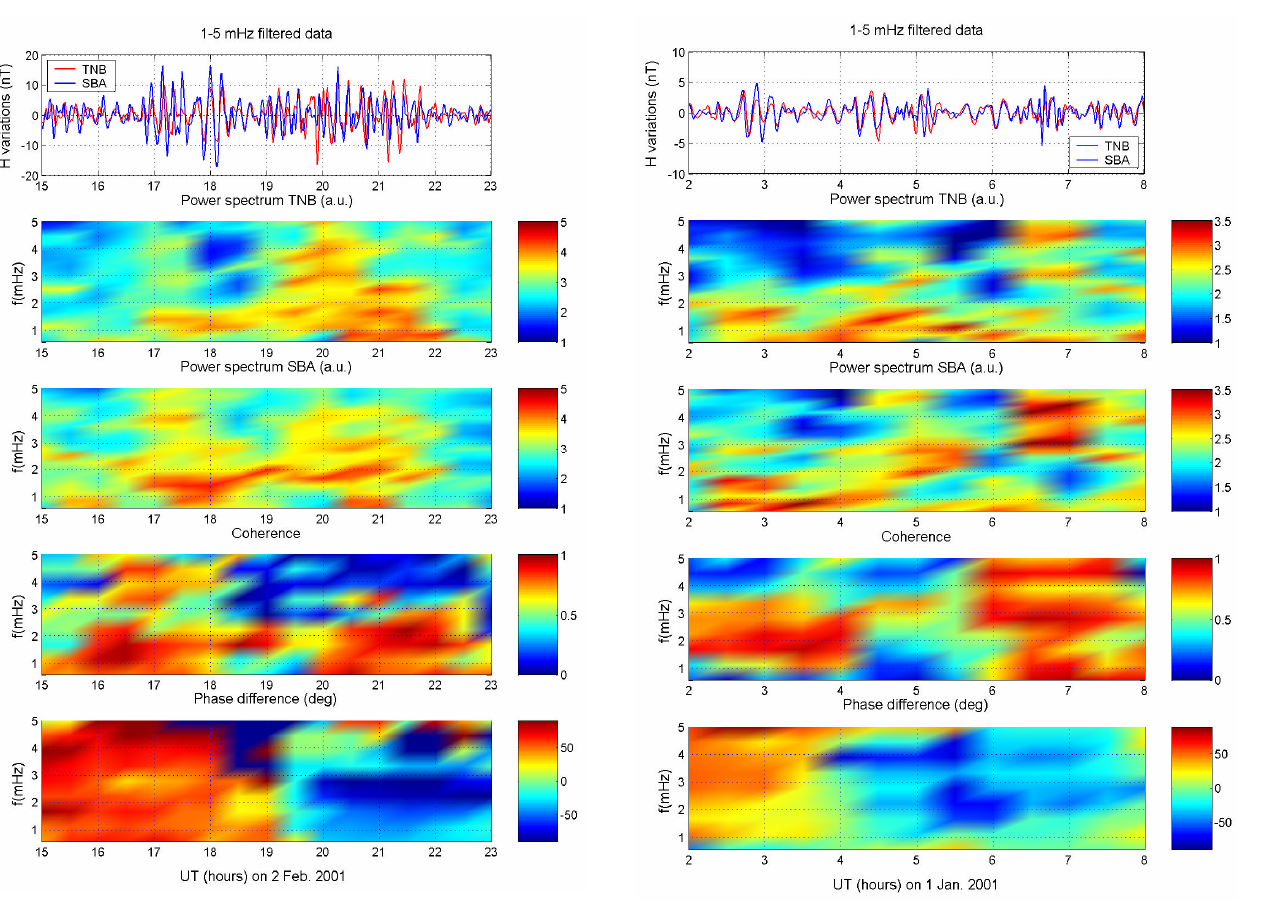
Fig. 7. The same of Fig. 6, for the event occurring between 02:00 and 08:00 UT on 1 January 2001. MLT midnight at SBA and TNB is at 07:00 and 08:00 UT,